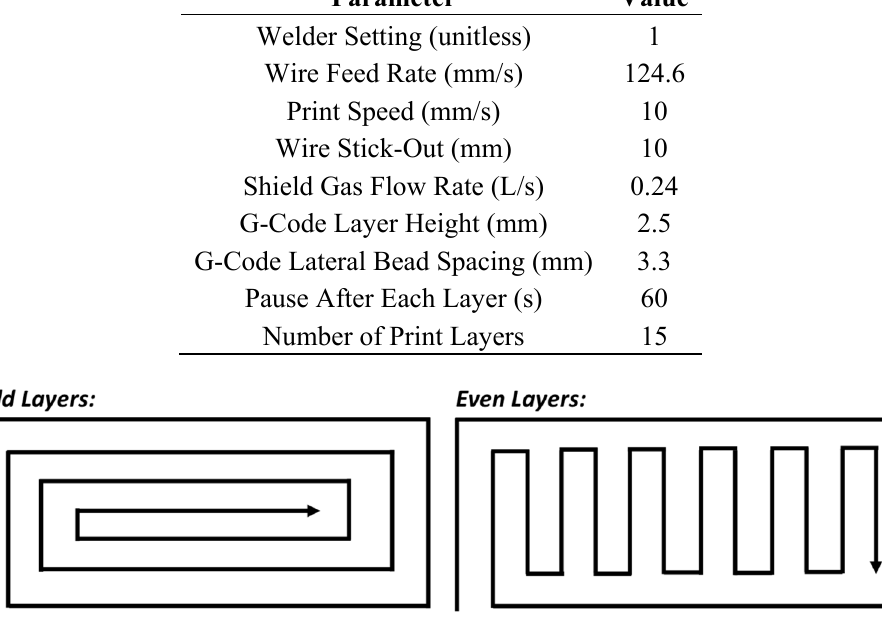
Figure 6. Alternating print paths viewed in the direction of the z-axis.